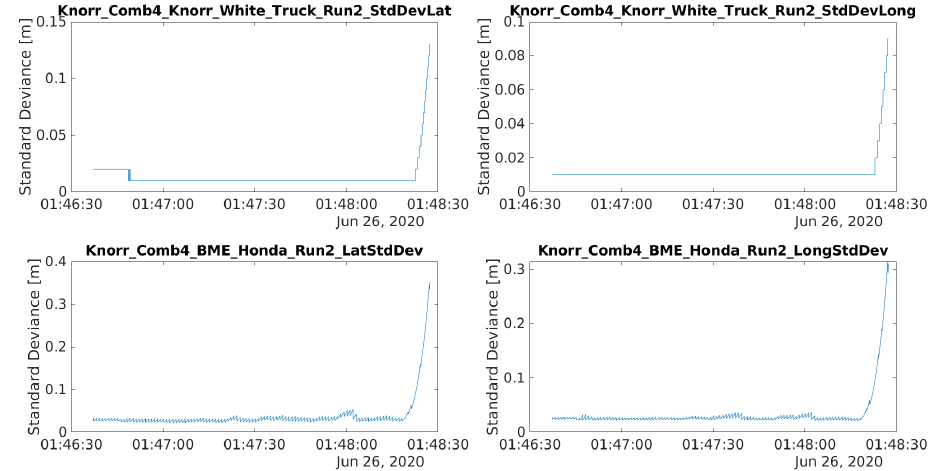
Figure 25. Quality information from all the logs for a test